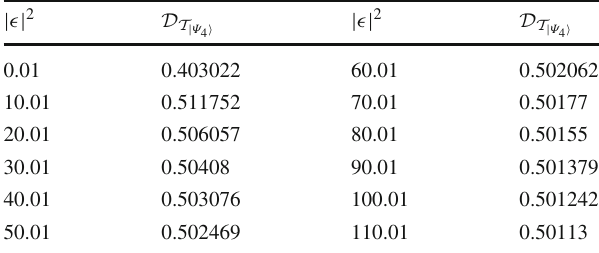
Table 7 Numerical values of D T parameter in | Ψ 4 (cid:3) state for coherent parameter | (cid:11) |